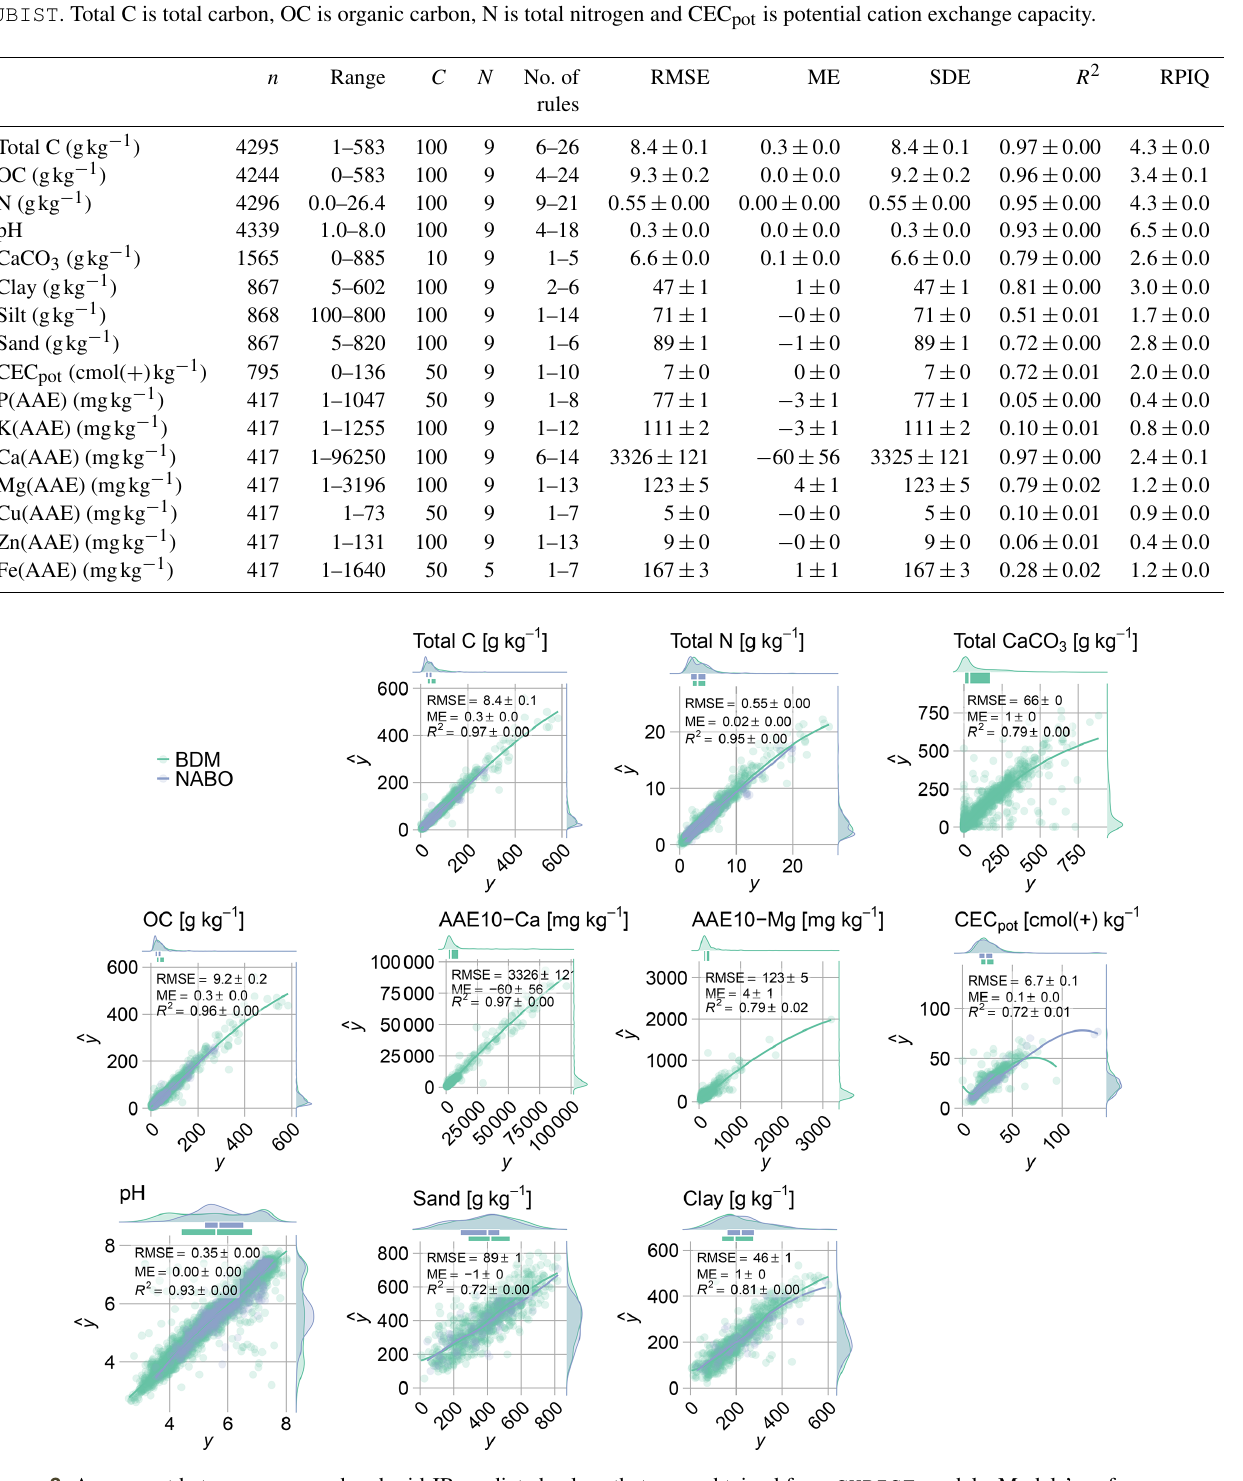
Figure 3. Agreement between measured and mid-IR predicted values that were obtained from CUBIST models. Models’ performance was assessed by site-grouped cross-validation holdouts (five times repeated 10-fold). The lines obtained with local regression (LOESS) smoothing indicate the trends in predictions. Models of soil properties with R 2 ≥ 0 . 72 are shown (see Table 2 for more detailed model